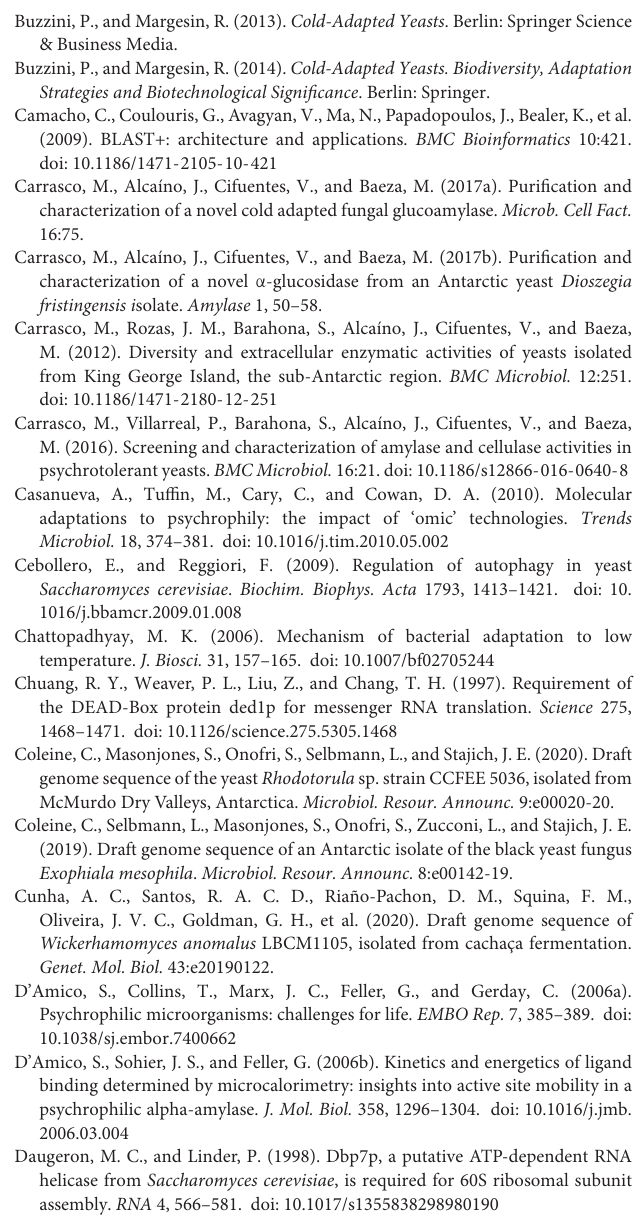
with R 2 ≥ 07 are shown. ANT, Antarctic yeasts, and NCBI ranges T10-22, T23-28, and T30-37. In parentheses, the mode values for each group are given. Supplementary Figure 6 | Principal component analysis among changes in amino acid parameters of CDS groups, optimal temperature for growth (T) and growth rate (G) of yeasts. Supplementary Table 1 | Summary of draft genome of Antarctic yeasts. Supplementary Table 2 | Number of CDS predicted to encode genes related to different stress responses in each yeast. Supplementary Table 3 | Comparison of amino acid content of CDS groups among yeasts. Only the results with significant differences are shown (ANOVA-Tukey, p < 0.05).